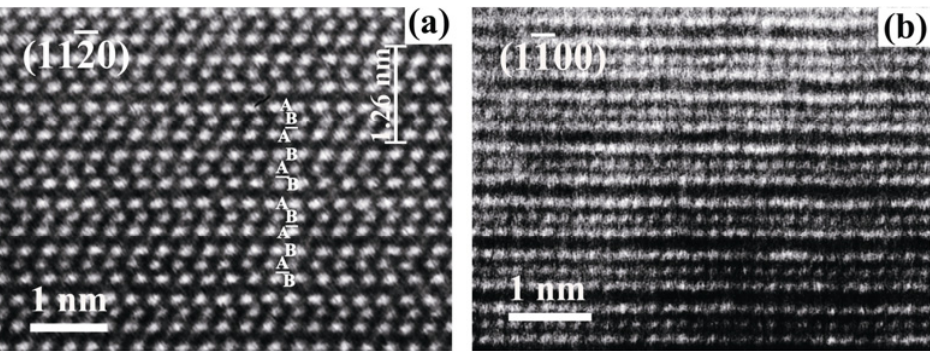
Fig. 8 HRTEM images of Zr 2 SeB with atomic arrangement on (a) (11¯20) plane and (b) (1¯100)